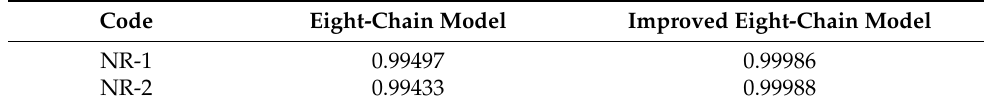
Figure 7. The residual error of fitting results of eight-chain model and improved eight-chain model for filled rubber under uniaxial tension, ( a ) NR-1; ( b ) NR-2. Table 2. The goodness of fit of hyperelastic models based on uniaxial tension data at 283